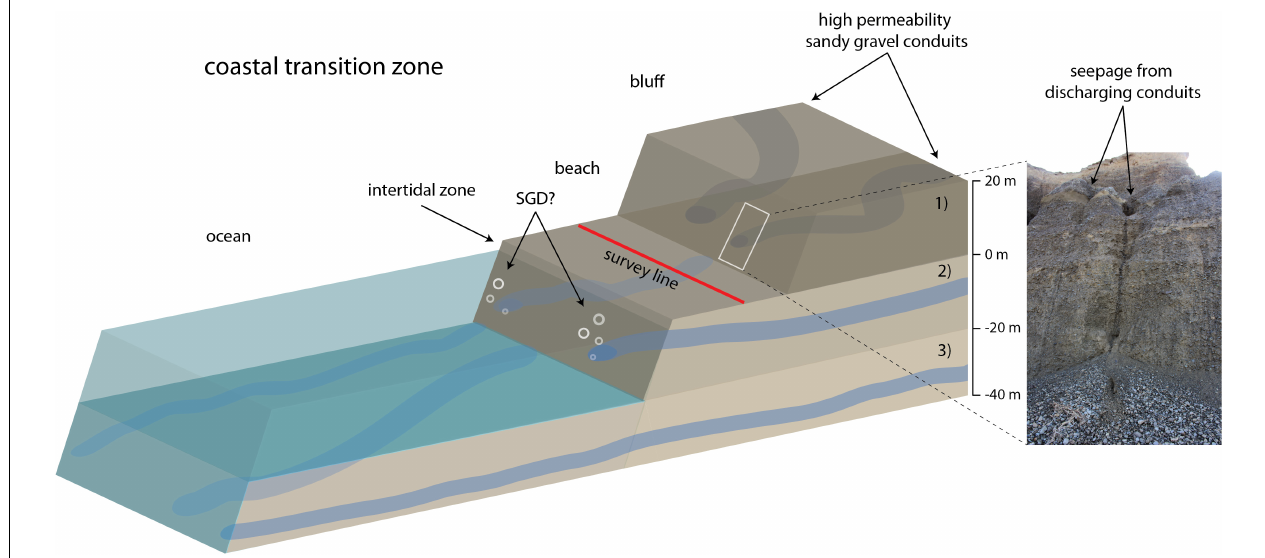
FIGURE 13 | Conceptual discharge model illustrating the configuration of (from top to bottom): (1) high permeability sandy gravel conduits within the coastal bluffs and photograph from the field showing evidence for seepage on the bluff face, (2) shallow conduits in the unconfined aquifer potentially discharging in the nearshore at SGD sites, and (3) deeper conduits connecting the onshore/offshore coastal groundwater system. Approximate depth scale on the right of the right side of the cartoon roughly corresponds to the depths of the conduits in the observed data shown in Figure 10